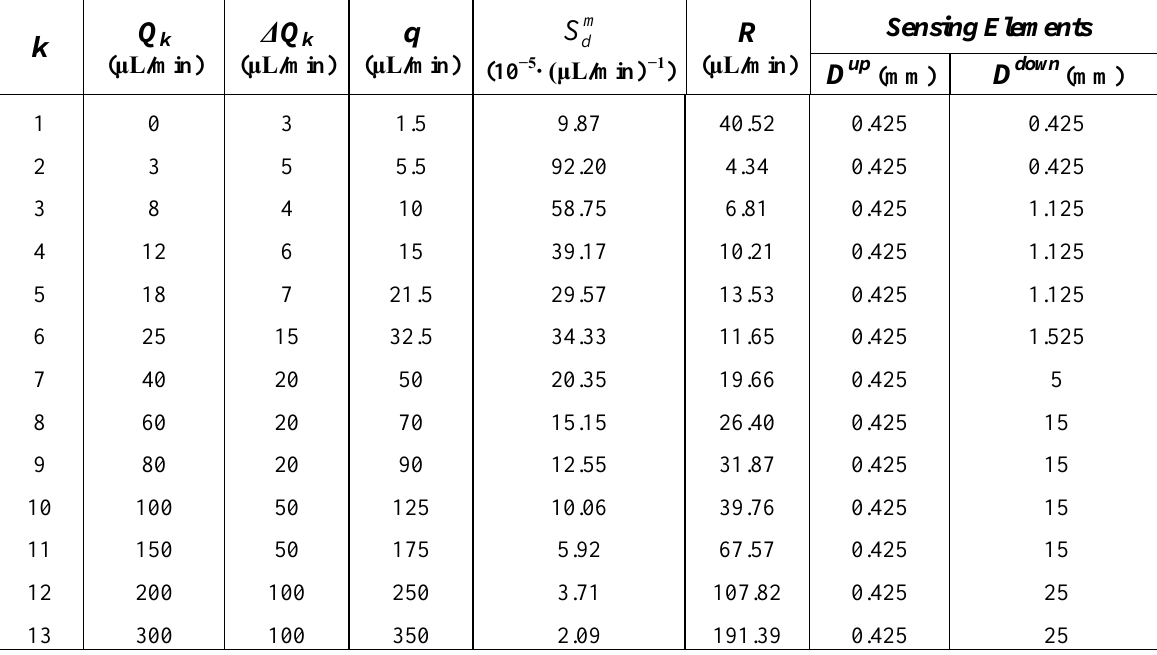
Table 1. The information regarding the device sensitivity, resolution as well as the corresponding sensing element combination as extracted by processing the data of Frame